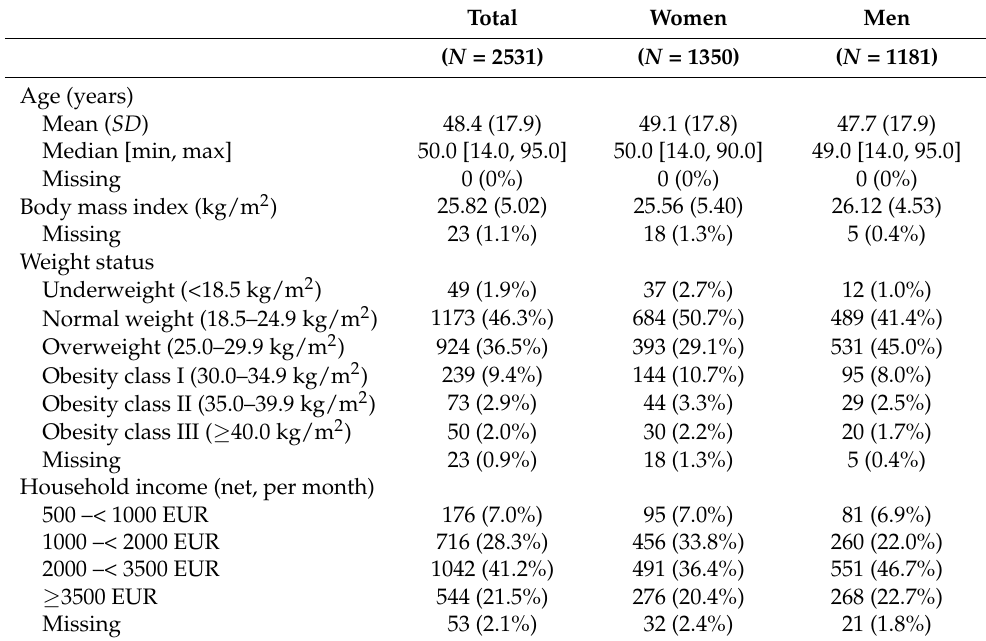
Table 1. Demographic characteristics of the study